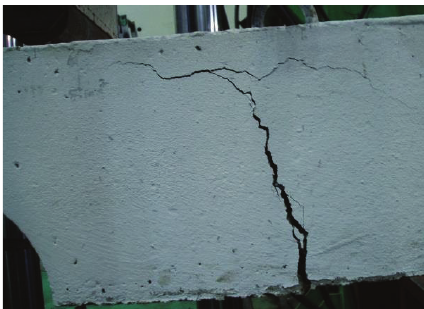
Figure 8: Concrete splitting failure.